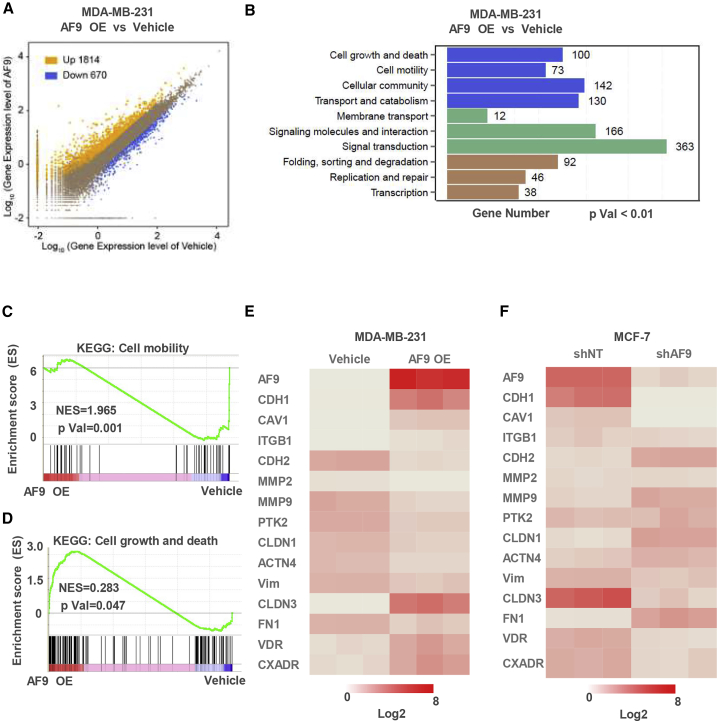
AF9 Regulates the Expression of EMT-Related Genes(A–D) In MDA-MB-231-Vehicle cells and MDA-MB-231-AF9 OE cells, RNA-seq was performed to investigate the AF9-regulated gene profiles. (A) Scatterplot showing that overexpression of AF9 increased the expression of 1,814 genes and decreased the expression of 670 genes. (B) The top 11 pathways (scoring by gene number and p value) using a Kyoto Encyclopedia of Genes and Genomes (KEGG) pathway analysis with a p value cutoff < 0.01, and the gene number is shown in the figure. (C and D) Gene Set Enrichment Analysis (GSEA) of cell mobility or cell growth and death are shown. (E) 14 genes regulating cell mobility were identified by qPCR with a ratio value of the gene expression levels of the AF9 OE group versus the Vehicle group of the MDA-MB-231 cells. The data are representative of at least three independent experiments. (F) 14 genes regulating cell mobility were identified by qRT-PCR with a ratio value of the gene expression levels of MCF-7-shNT cells and MCF-7-shAF9 cells. The data are representative of at least three independent experiments.